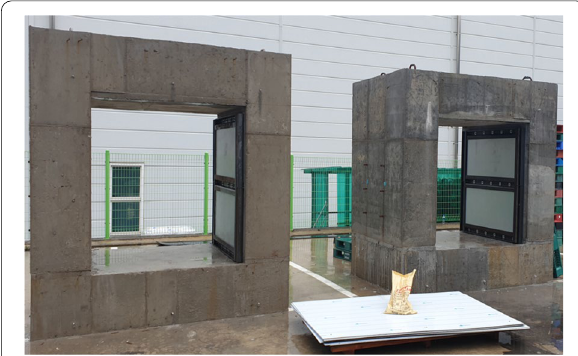
Fig. 3 Reinforced concrete structures for experiment (left structure; normal strength concrete, right structure; high‑strength concrete).